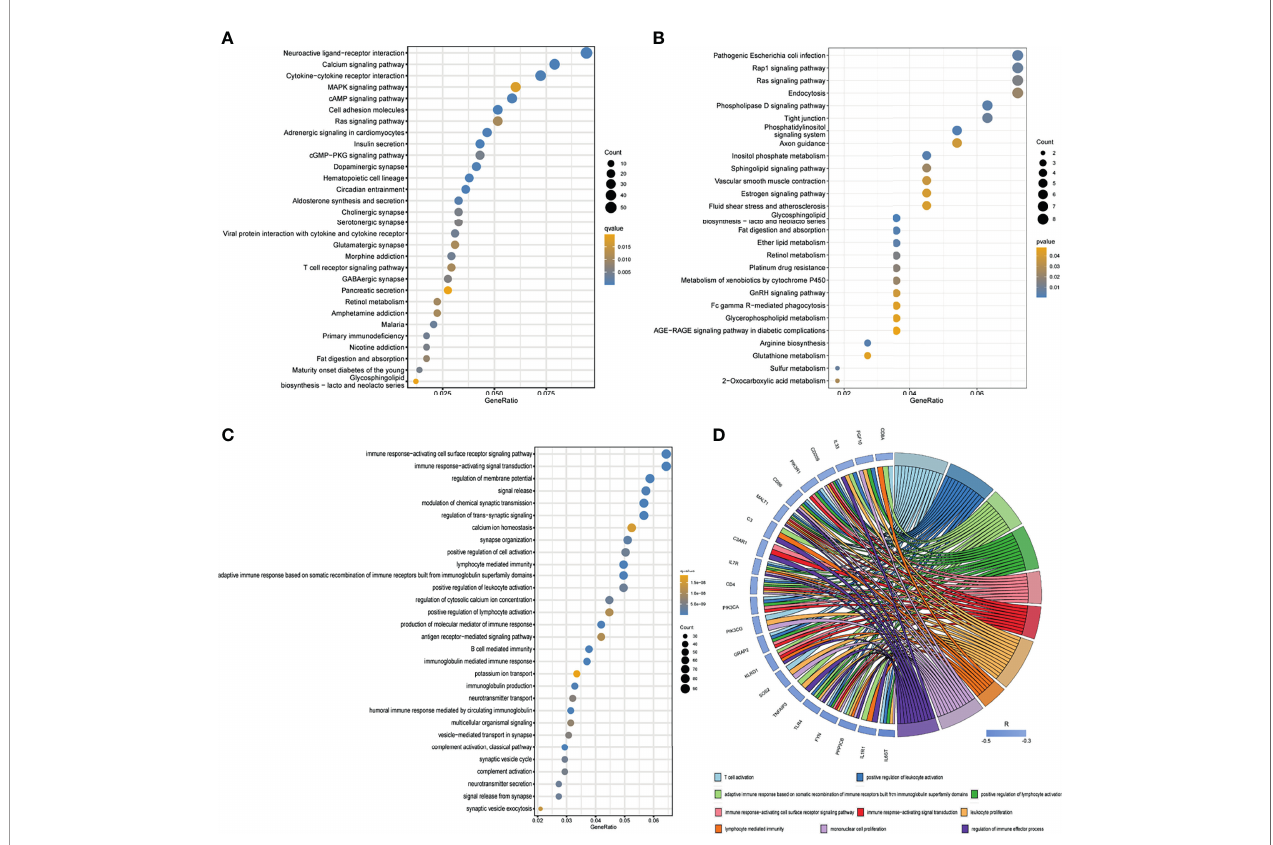
FIGURE 5 | Results of KEGG enrichment and GO analysis. (A) KEGG pathway analysis of DEGs based on TCGA database. (B) KEGG pathway analysis of co- expressed genes based on TCGA database. Only pathways with a P-values <0.05 are presented. (C) GO analysis (biological process) of DEGs based on TCGA database. (D) GO analysis (biological process) of co-expressed immune genes in PDAC. Negatively co-expressed IRGs are